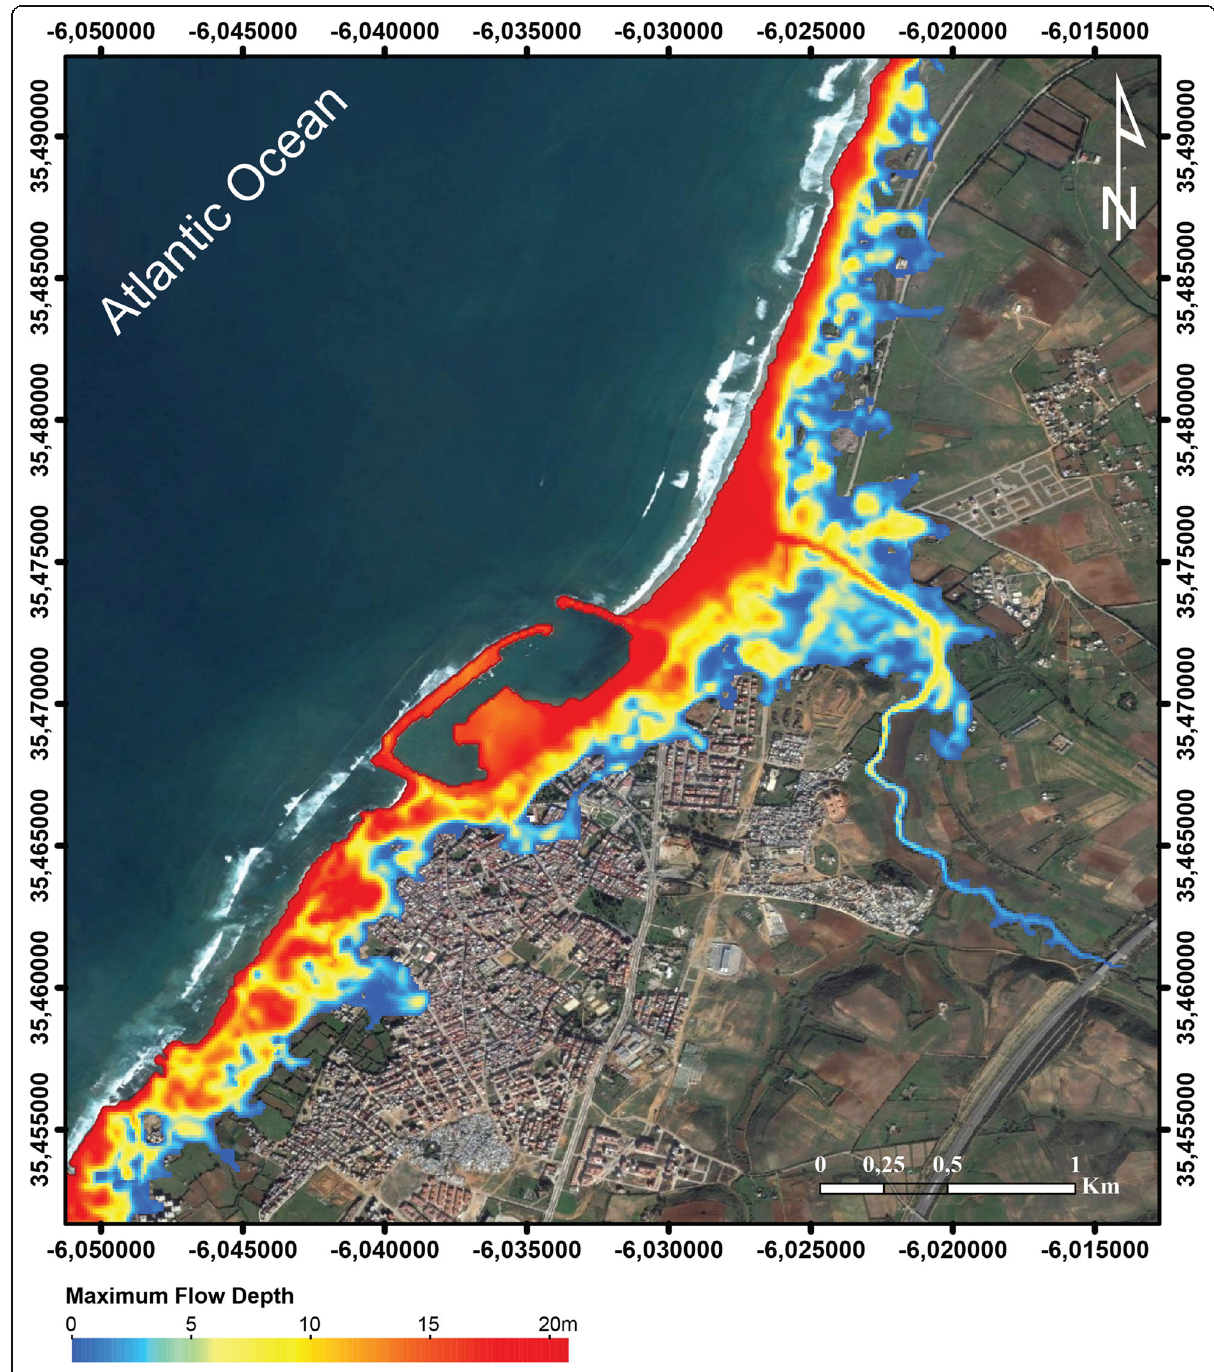
Fig. 5 Results inundated area and maximum flow depths, for the aggregate scenario considering MSL. MFD are represented by the color bar (in